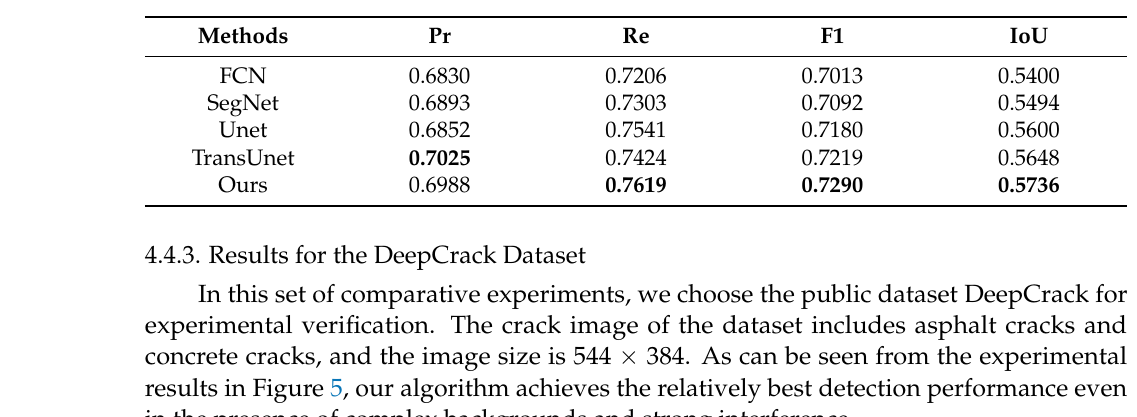
Figure 4. Comparison of predicted results among various methods for the Crack500 dataset. Columns from left to right: ( a ) original image, ( b ) ground truth, ( c ) FCN, ( d ) Unet, ( e ) SegNet, ( f ) TransUnet, and ( g ) our method. Table 3. The Pr, Re, F1, and IoU of compared methods for the Crack500 dataset.